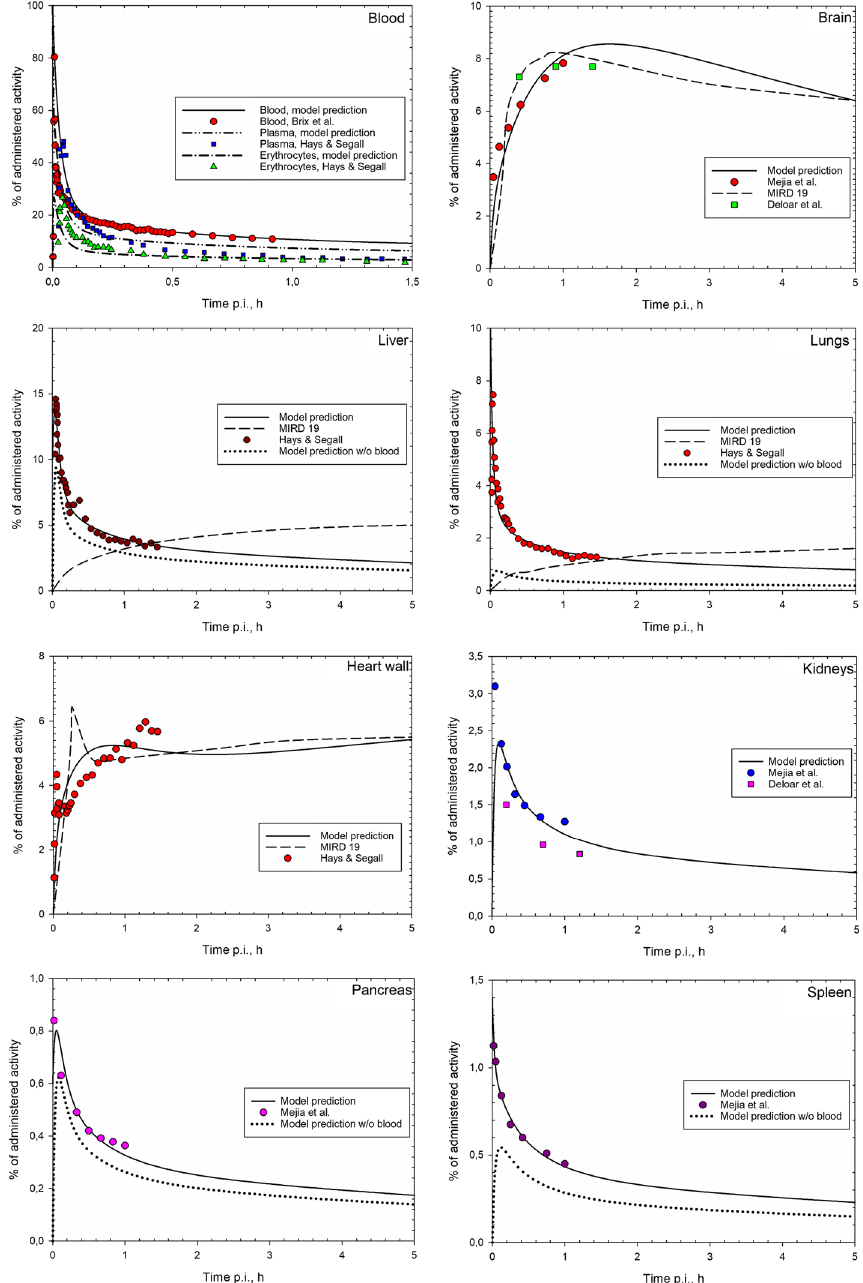
Fig. 2 Decay‑corrected TACs in source regions predicted by the proposed biokinetic model along with the experimental data (scattered points; decay‑corrected to the time of injection). For comparison, TACs reported in MIRD dose estimate report 19 [3] are given in dashed lines. For liver, lungs, pancreas and spleen, the TACs predicted by the proposed model for organ parenchyma only (i.e. without organ blood content) are shown in dotted lines. Activity of 2‑[ 18 F]FDG is given in % of administered